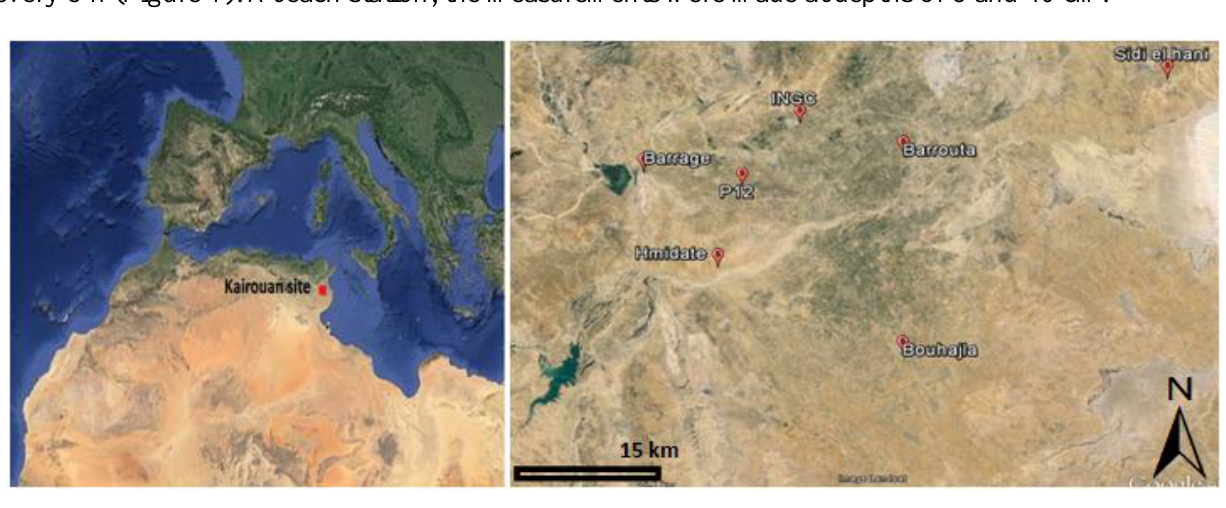
Figure 1. Localization of the study site and the seven continuous thetaprobe stations.